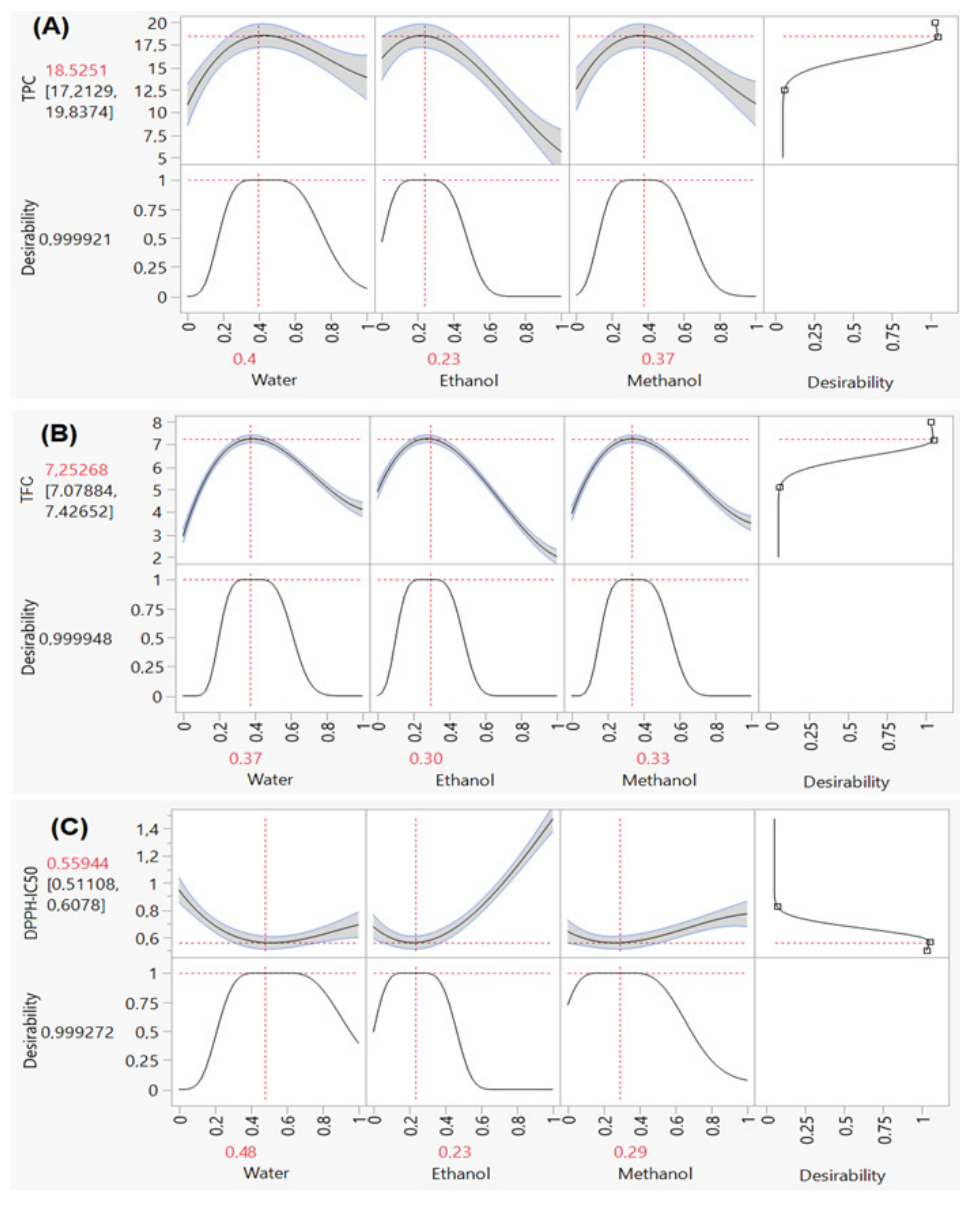
Figure 5. Desirability plots used to identify the optimum value of TPC ( A ), TFC ( B ) and DPPH IC50 ( C ), separately.